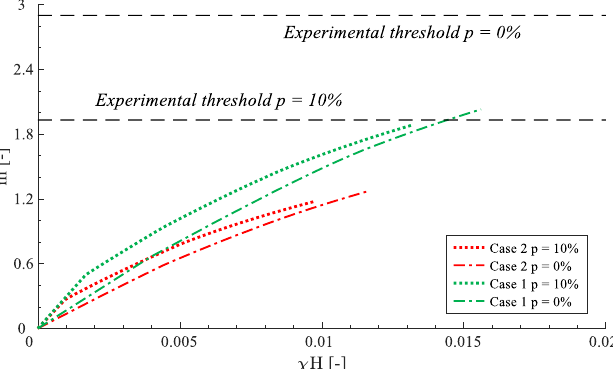
Figure 11. Figure 11. Comparison between numerical bending moment – curvature diagrams and experimental values.